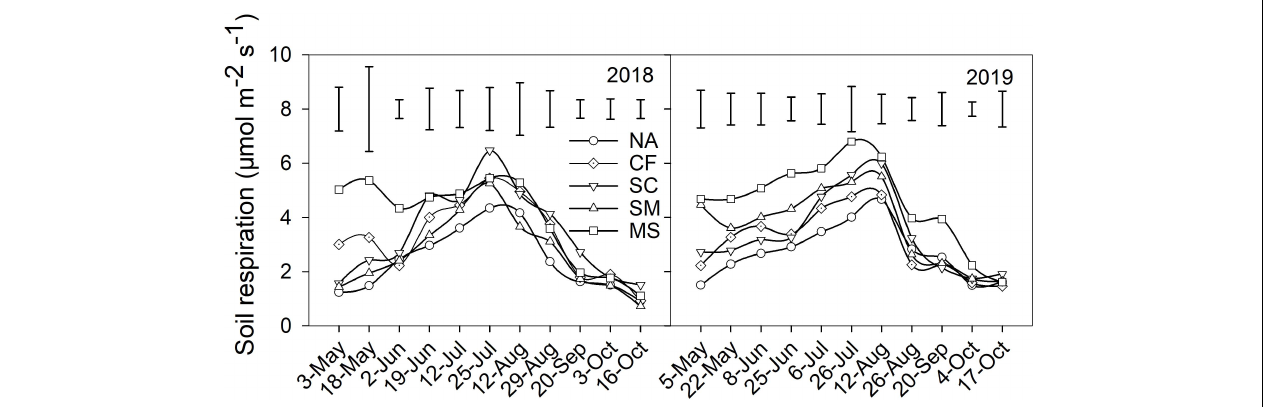
FIGURE 1 | Soil respiration under five treatments during the 2018 and 2019 growing seasons. Vertical bars indicate the least significant difference value at P < 0.05. NA, no amendment; CF, chemical fertilizer; SC, 50% chemical N fertilizer plus 50% organic N fertilizer; SM, organic fertilizer; MS, maize straw.